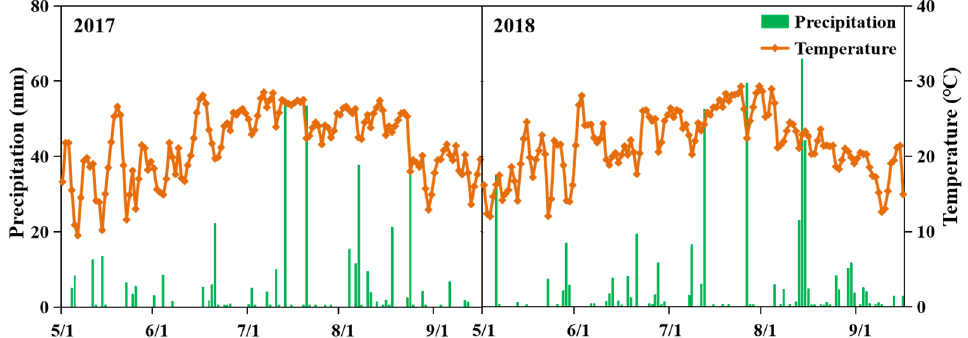
Figure 6. Temperature and precipitation during the test